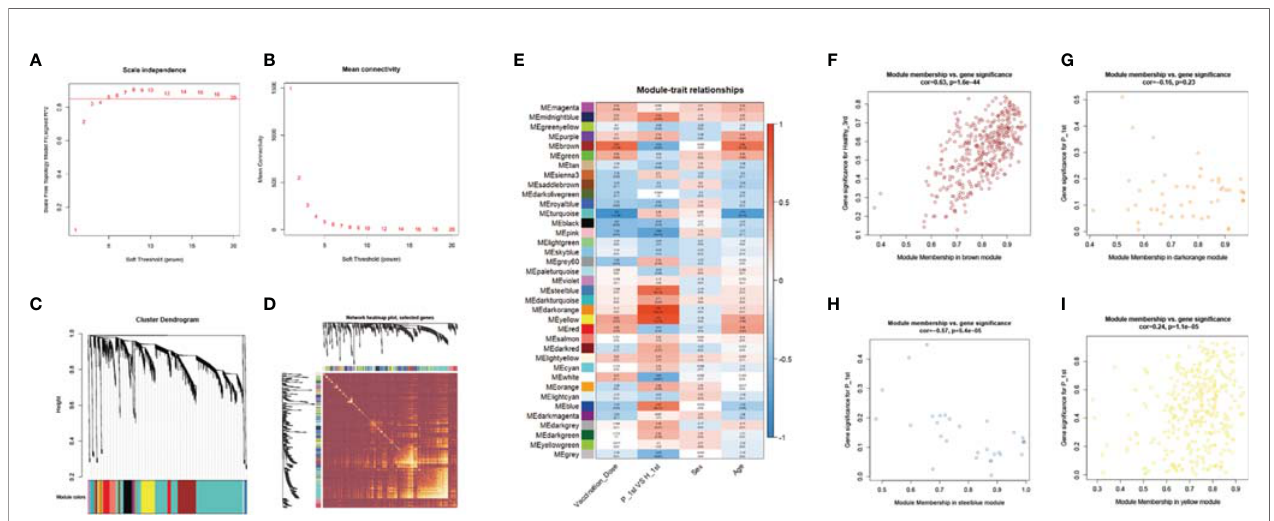
FIGURE 6 | WGCNA of the PBMCs transcriptome. (A, B) Analysis of network topology for various soft-thresholding powers. The left panel shows the scale-free fi t index (y-axis) as a function of the soft-thresholding power (x-axis). The right panel displays the mean connectivity (degree, y-axis) as a function of the soft-thresholding power (x-axis). (C) Clustering dendrogram of genes, with dissimilarity based on topological overlap, together with assigned module colors. (D) Heatmap depicts the Topological Overlap Matrix (TOM) of genes selected for weighted co-expression network analysis. Light color represents lower overlap and red represents higher overlap. (E) Module-trait associations: Each row corresponds to a module eigengene and each column to a trait. Each cell contains the corresponding correlation and p-value. (F – I) Scatter diagram for MM vs GS in the brown, darkorange, yellow and steelblue